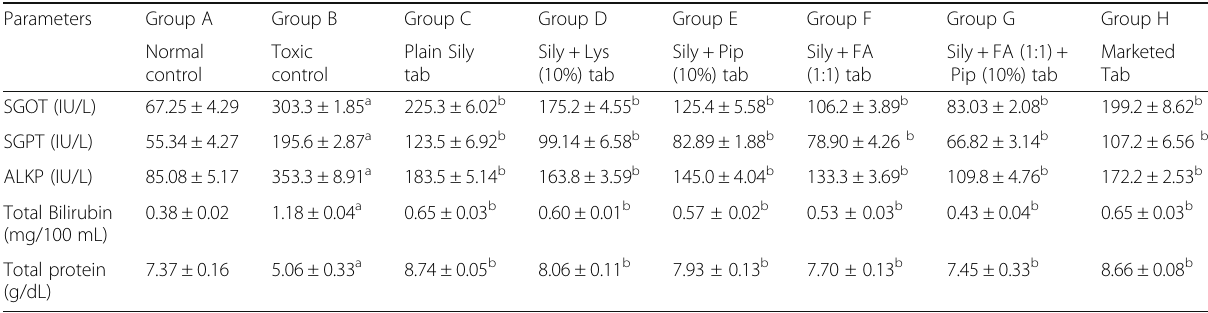
Table 1 Summary of biochemical parameters for all treatment groups